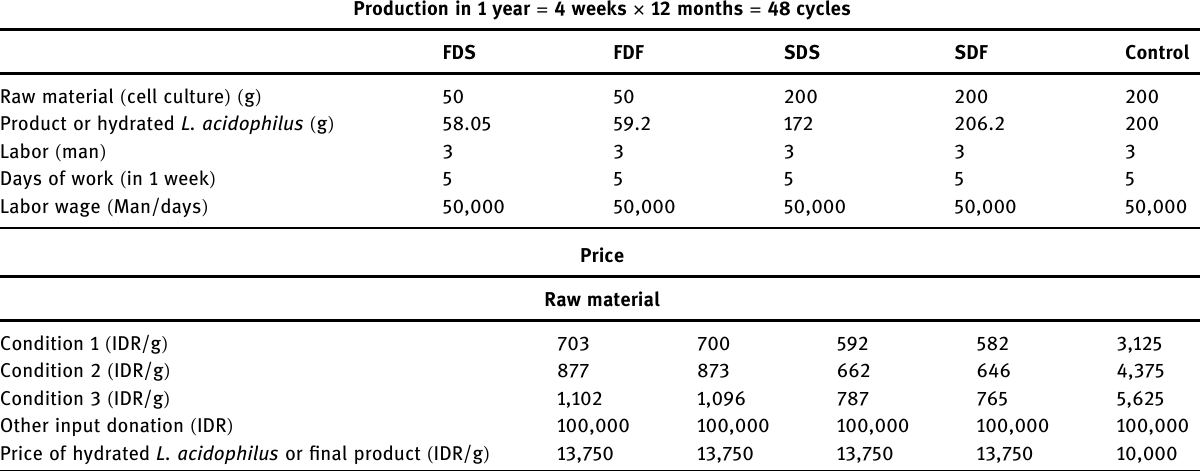
Table 5: Raw material price and other input contribution in production of hydrated L. acidophilus